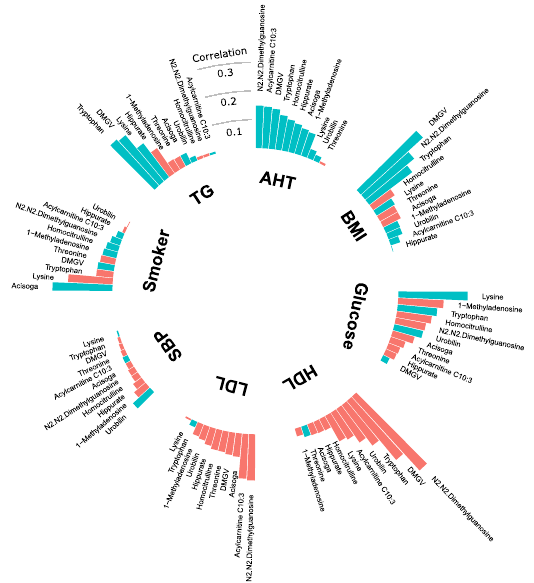
Figure 4. Correlations between plasma levels of 11 plasma metabolites and BMI, smoking status (Smoker), systolic blood pressure (SBP), anti-hypertensive treatment (AHT) and fasting levels of HDL cholesterol (HDL), LDL cholesterol (LDL), triglycerides (TG) and glucose in the Malmö Preventive Project ( n = 369). Correlation coefficients are either partial Spearman’s correlation coefficients (BMI, glucose, HDL, LDL, TG, SBP) or partial Pearson’s correlation coefficients (Smoker and AHT), adjusted for age and sex.